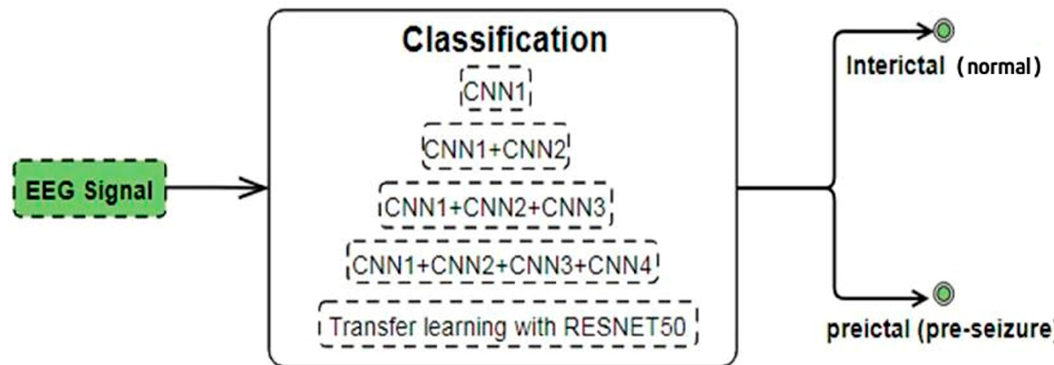
Figure 1. Overview of proposed method.